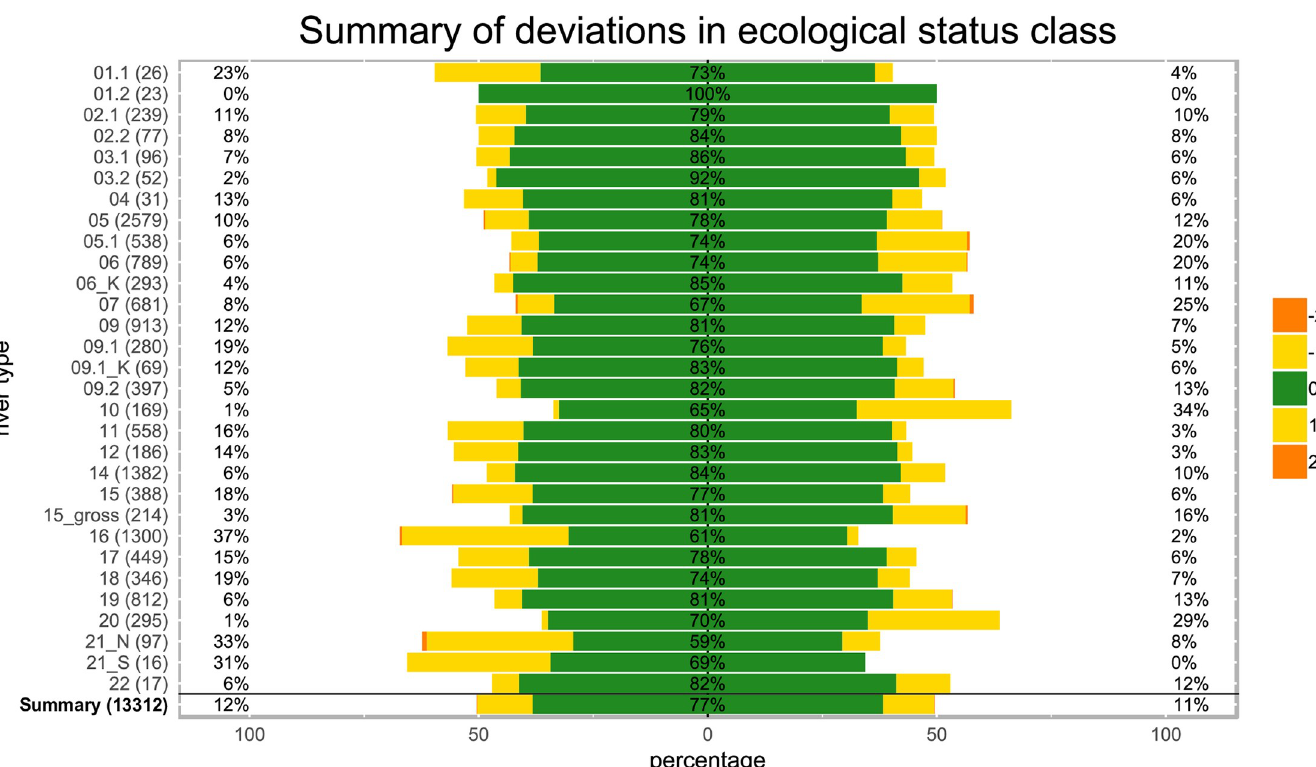
Fig 2. Deviations in ecological status class (ESC) estimates obtained from presence/absence data using ASTERICS for 13,312 samples from 30 German stream types (y-axis, numbers in parentheses = data points). Green indicates the proportion of ESCs that remained identical, yellow indicates those that differed by ± 1 and orange indicates those that differed by ± 2 ESCs. Deviations in the negative (worse) direction are shown on the left and deviations towards a more positive assessment (better) are shown on the right side.